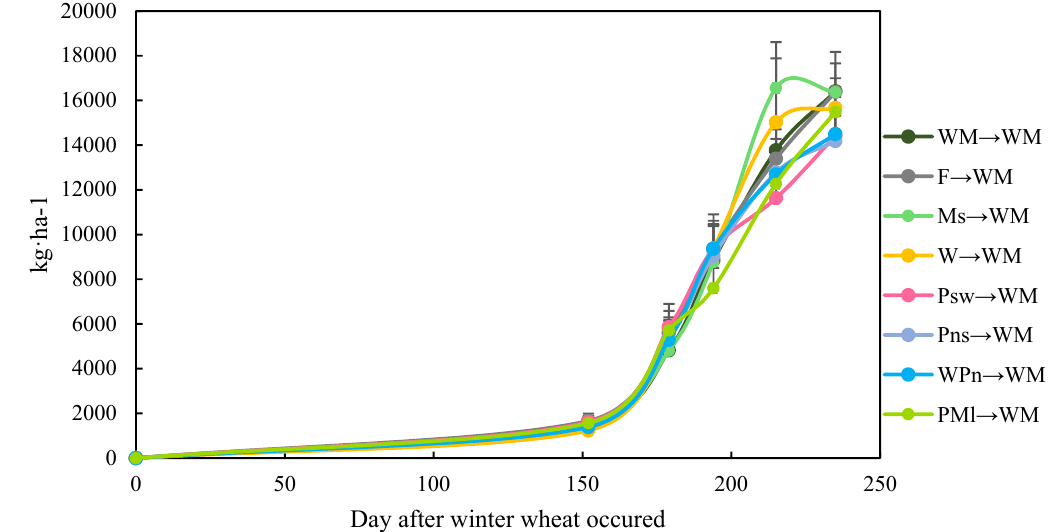
Figure 3. Aboveground biomass of 2017 / 2018 winter wheat growing season over time within each rotation. WM → WM, winter wheat–summer maize → winter wheat–summer maize; F → WM, fallow → winter wheat–summer maize; Ms → WM, spring maize → winter wheat–summer maize; W → WM, winter wheat → winter wheat–summer maize; Psw → WM, sweet potato → winter wheat–summer maize; Pns → WM, spring peanut → winter wheat–summer maize; WPn → WM, winter wheat–summer peanut → winter wheat–summer maize; PMl → WM, potato–silage maize → winter wheat–summer maize.